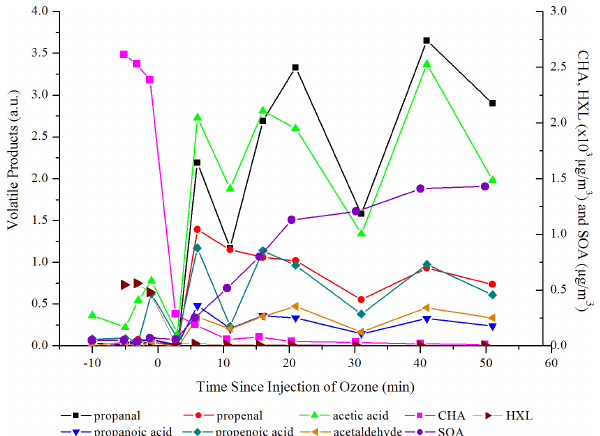
Fig. 5. Reaction profile of the ozonolysis of a 5:1 mix of CHA and HXL (initial concentration 2.5 ( ± 0.1) × 10 3 µgm − 3 and 0.5 ( ± 0.04) × 10 3 µgm − 3 , respectively). 800ppb ozone was injected at time zero, after which SOA and volatile products (propanal, propenal, propenoic acid, acetic acid, propanoic acid, acetaldehyde) increased in signal. Lines between data points drawn to aid the eye.